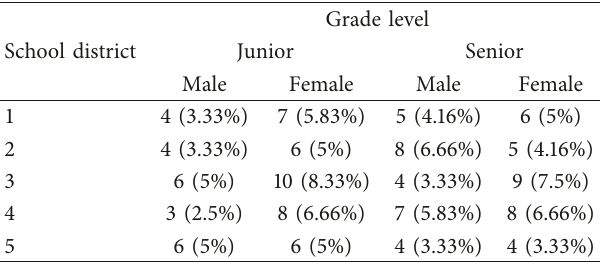
Table 2: The proportion of teachers in the randomly selected sample in which stratification variables were related to gender and the school